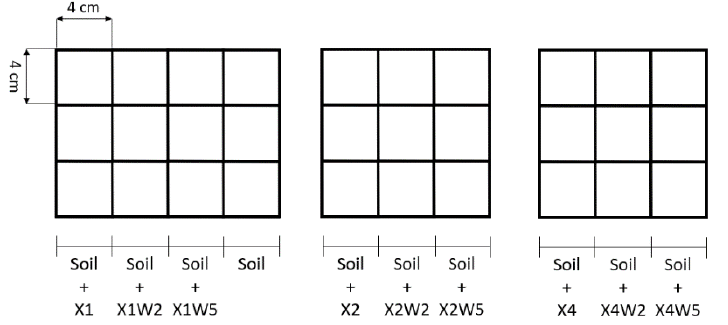
Figure 15. Schematization of the experiment for the evaluation of the grass growth with soil condi-